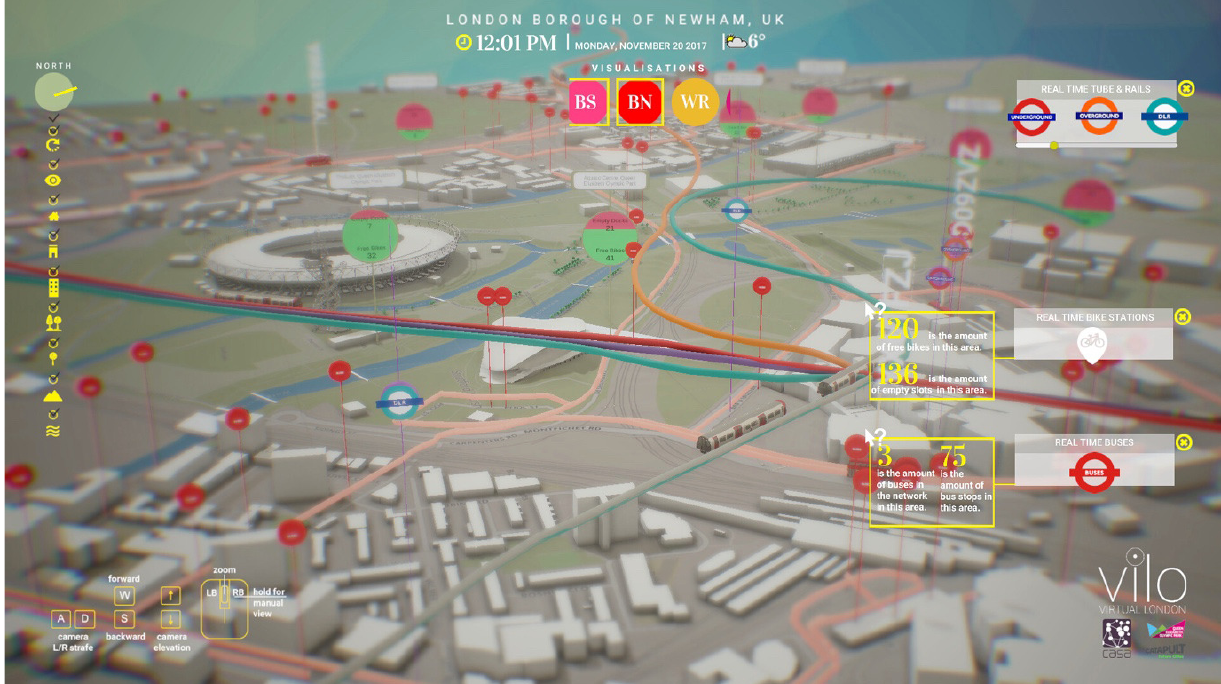
Figure 5. The ViLo digital twin model with real‐time